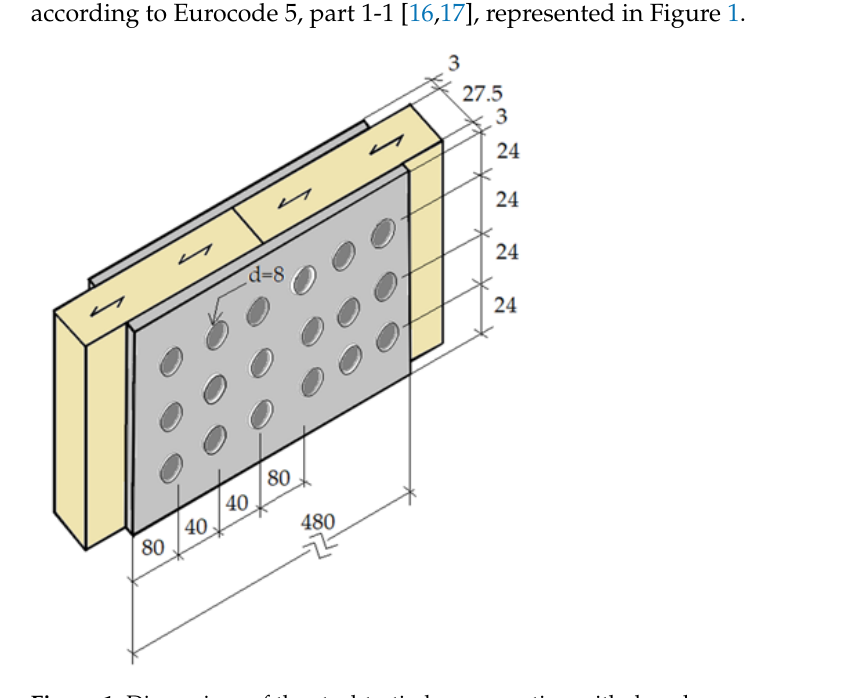
Figure 1. Dimensions of the steel ‐ to ‐ timber connection with dowels.